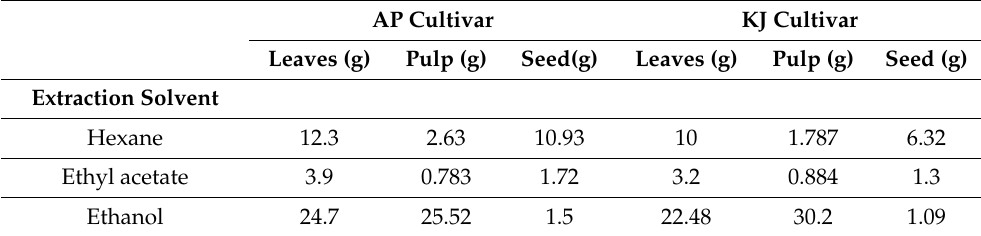
Table 2. The final weight of crude extracts of A. atemoya